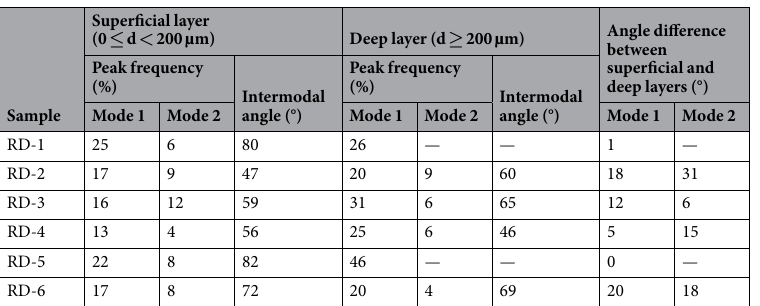
Table 1. Characteristics of the distribution of collagen fiber bundles in the superficial and deep reticular dermis in six samples (RD-1 to RD-6). Modes with the highest peaks with Gaussian fitting are defined as Mode 1. Modes that have the next highest peaks are defined as Mode 2. d indicates the depth from the papillary dermis– reticular dermis